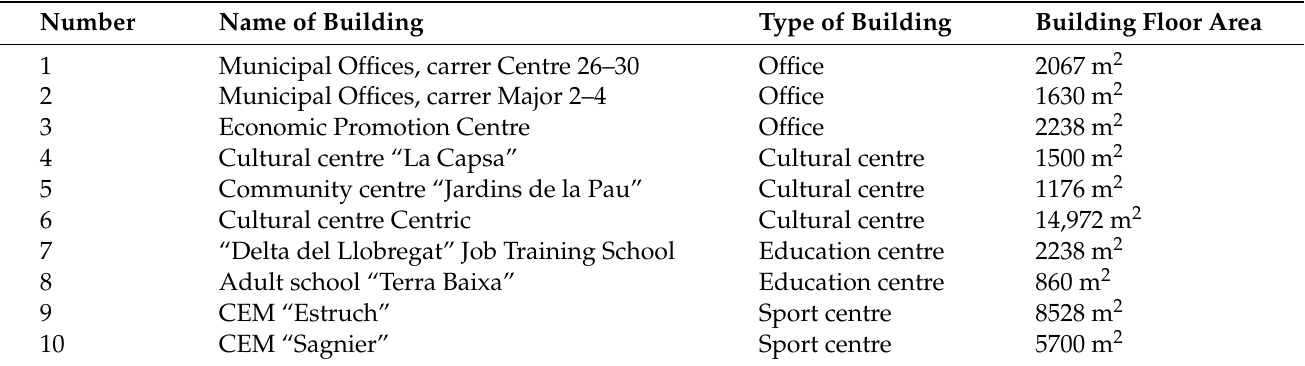
Table A1. List of buildings of Barcelona test site.